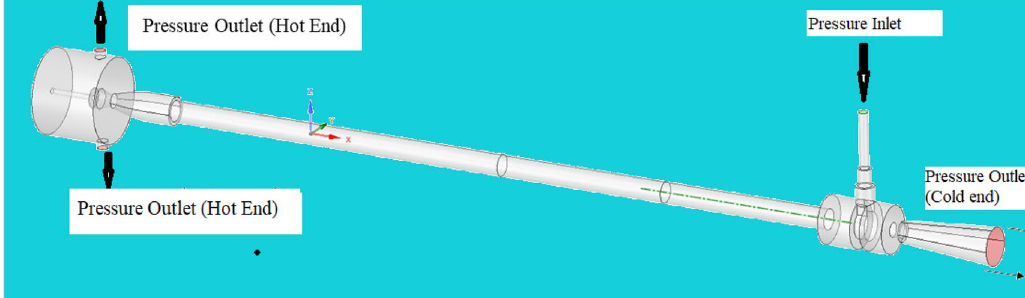
Figure 61. Boundary condition of vortex tube.